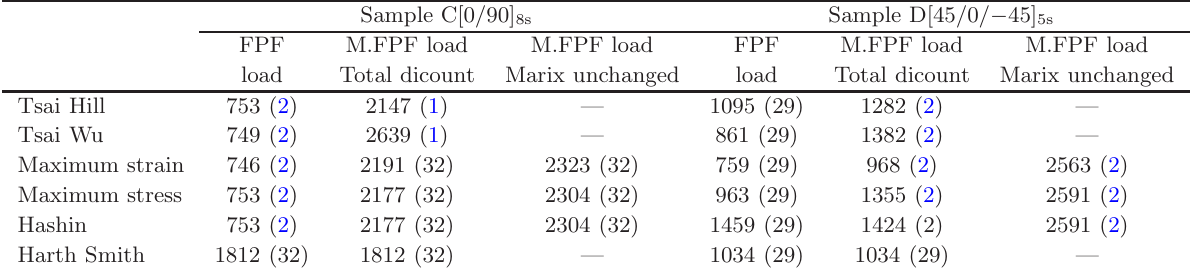
Table 6. Failure loads for samples C and